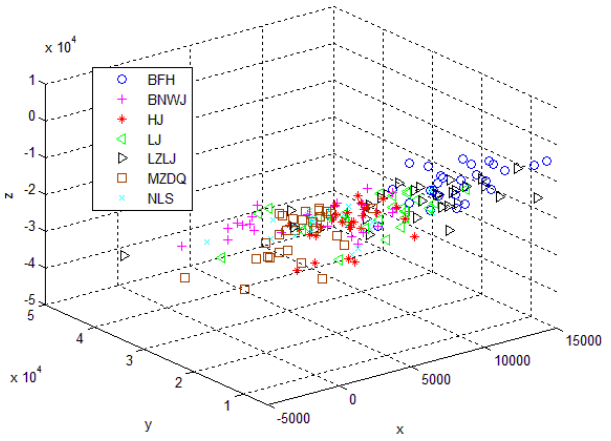
Figure 15. Response curves of the first generation e-nose platform.